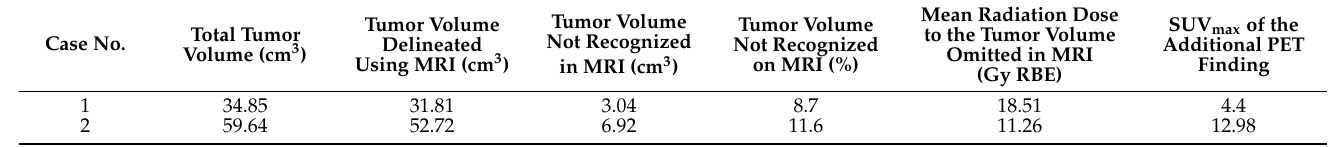
Table 2. Dosimetric evaluation of cases with critical new information delivered by [ 68 Ga]Ga-DOTA PET/CT. Case